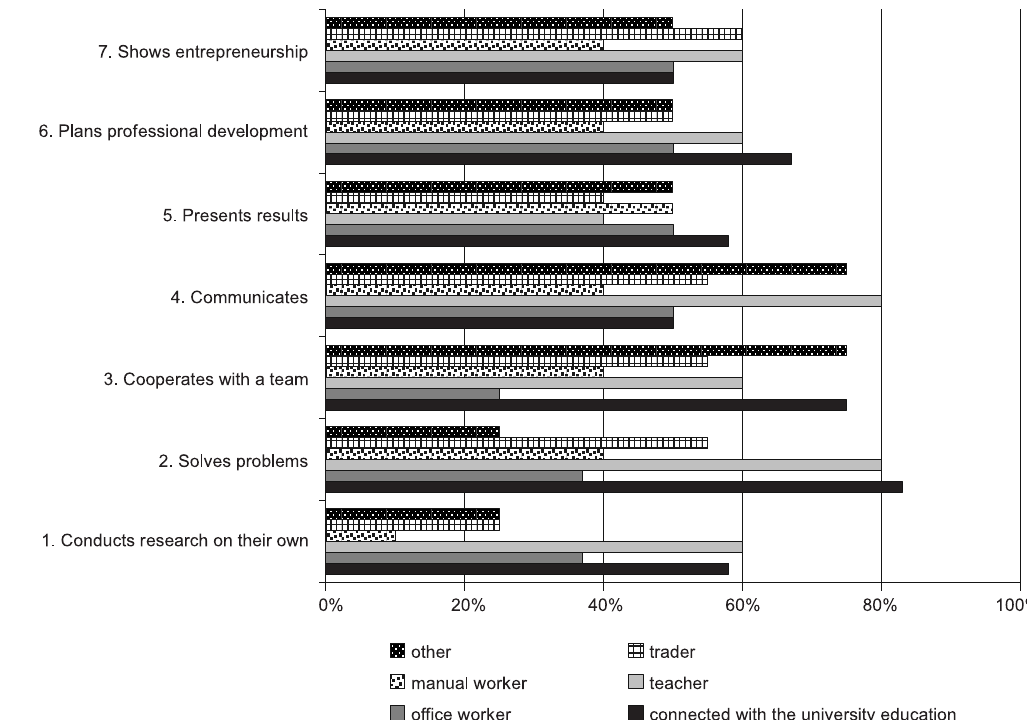
Fig. 4. Assessment of the usefulness of selected didactic competences – general geographic (hard) in the current work in the opinion of the surveyed students.